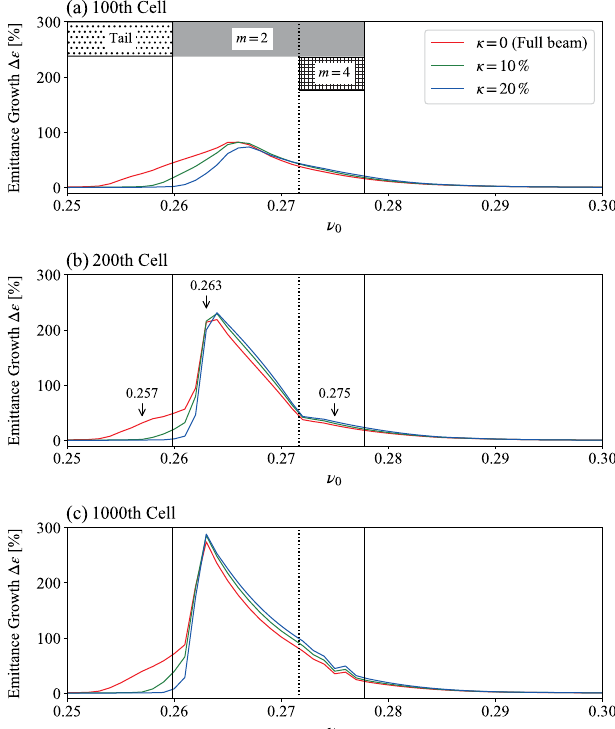
FIG. 3. Emittance growth of a Gaussian beam propagating through a long AG transport channel. The transport distances are (a) 100 FD cells, (b) 200 FD cells, and (c) 1000 FD cells. The rms tune depression is fixed at 0.9 regardless of the operating cell tune ν 0 . Vertical lines show the boundaries of the second-order ( m ¼ 2 ) and fourth-order ( m ¼ 4 ) coherent resonance bands estimated from Eqs. (3) and (5) with C 2 ¼ 0 . 7 and C 4 ¼ 0 . 9 . The phase-space configurations at the three operating tunes indicated by arrows in the middle picture are exhibited in Figs. 4 –